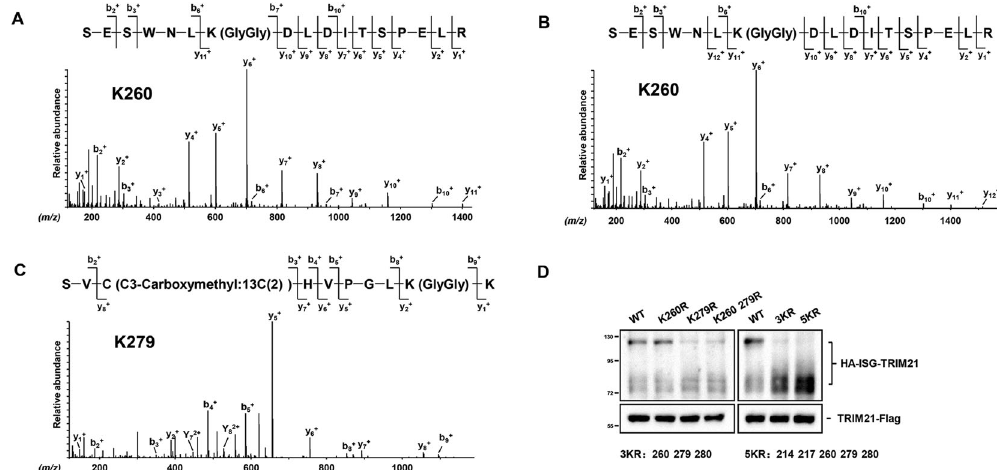
Fig. 3 Identi fi cation of ISGylation sites in TRIM21. A – C TRIM21-Flag, as well as the ISG15-conjugating system were overexpressed in HEK293 cells. Cell lysates were pulled down with anti-Flag af fi nity gel, and then subjected to SDS-PAGE separation and in-gel digestion. Iodoacetic acid- 13 C 2 , instead of iodoacetamide, was used in in-gel digestion to avoid false positive result. LC-MS/MS analysis identi fi ed Lys260 as original ISGylation sites in the bottom ISGylated TRIM21 band ( A ), and Lys260, Lys279 as original ISGylation sites in the top ISGylated TRIM21 band ( B , C ). D HEK293 cells were transfected for 24 h with ISG15-conjuating system and TRIM21 or indicated TRIM21 mutants, K260R, K279R, 2KR (K260/279R), 3KR (K260/279/280R), and 5KR (K214/217/260/279/280R). Cell lysates were subjected to anti-Flag pull-down, followed by immunoblotting with anti-HA and anti-Flag antibody. Data shown are representative of three independent